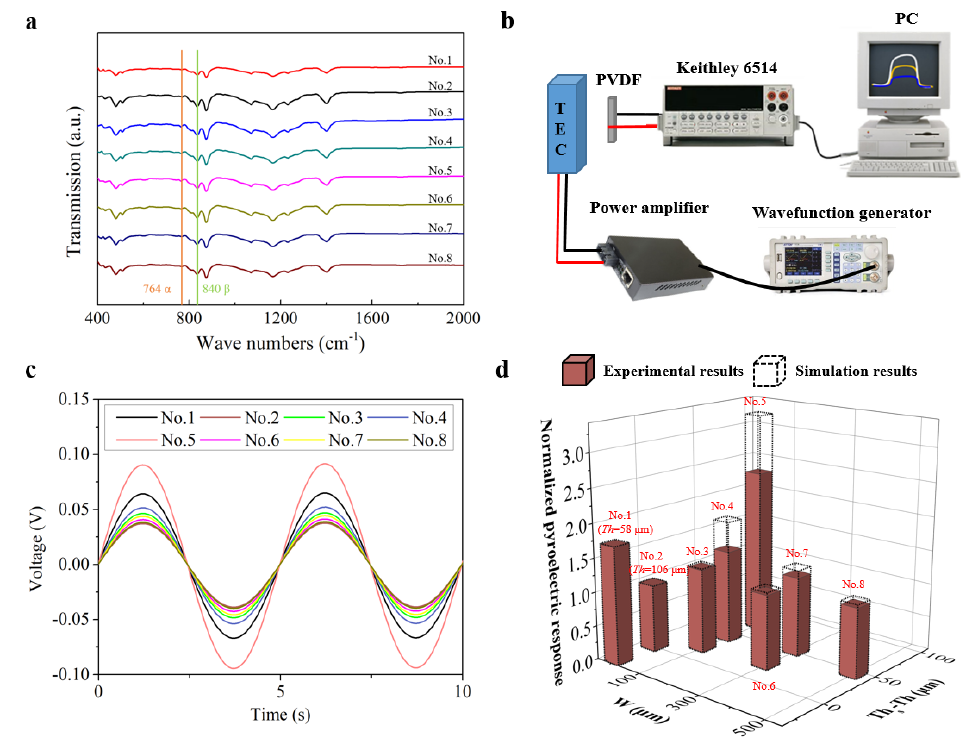
Figure 5. ( a ) FTIR spectra of PVDF samples. ( b ) Test platform for response performance of PVDF samples. ( c ) Real time response of PVDF samples. ( d ) Pyroelectric response results at different groove width ( W ) and depth ( Th s − Th ).